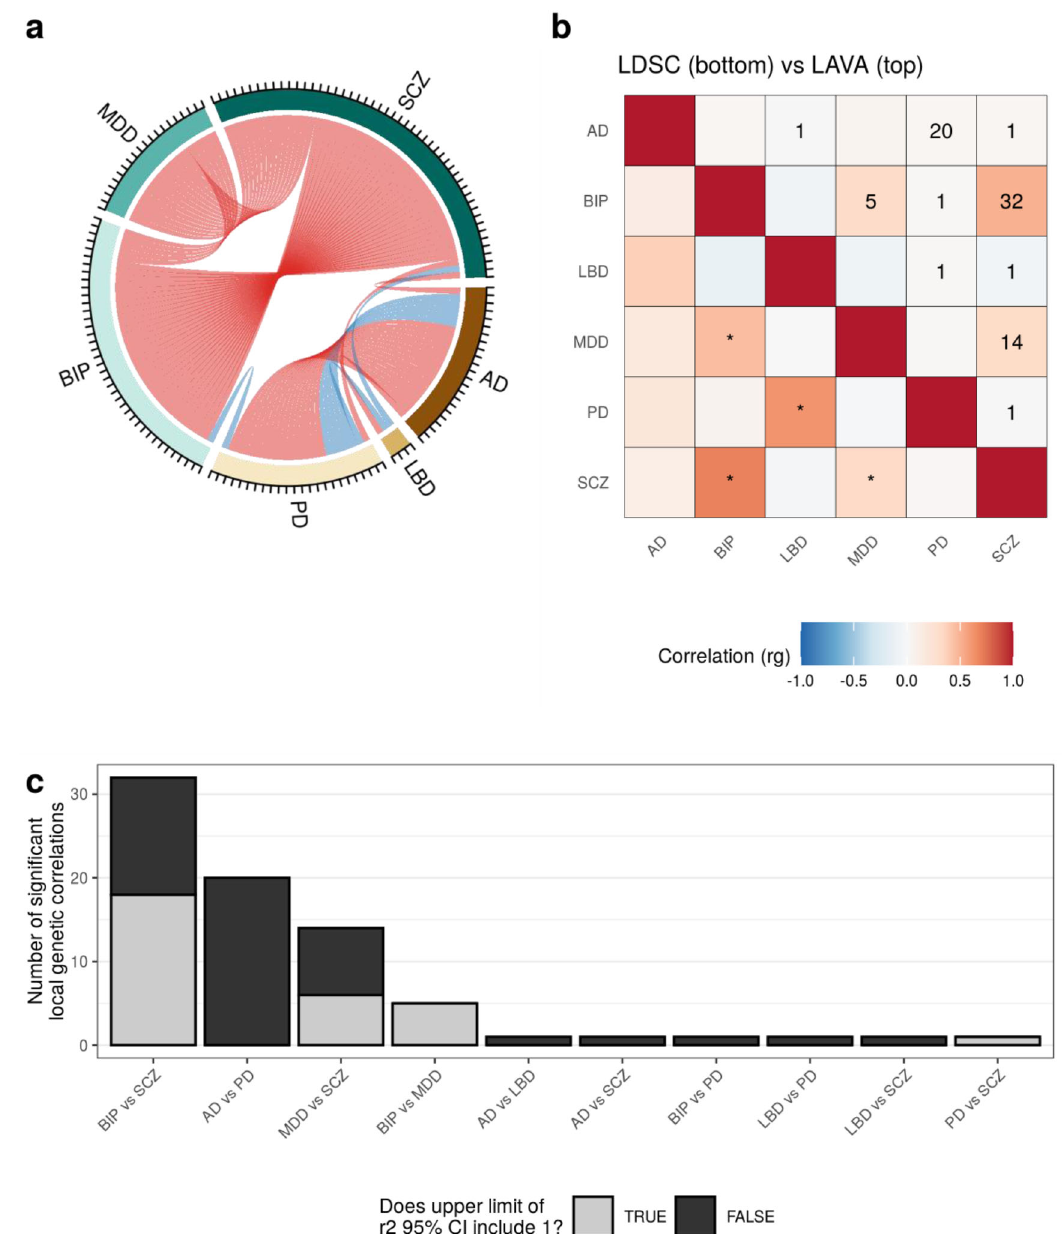
Fig. 1 Overview of local and global genetic correlations between neurodegenerative diseases and neuropsychiatric disorders. a Chord diagram showing the number of signi fi cant bivariate local r g s ( p < 0.05/1603) between each of the disease traits across all LD blocks. Positive and negative correlations are coloured red and blue, respectively. b Comparison between the global r g s estimated by LDSC (bottom) and the mean local r g from LAVA (top) across all tested LD blocks. Signi fi cant global r g s ( p < 0.05/15) are indicated with *. The number of signi fi cant local r g s is indicated by a number in each tile. c Bar plot showing the number of signi fi cant local r g s between disease trait pairs. The fi ll of the bars indicates the number of signi fi cant LD blocks for which the upper limit of the r 2 95% con fi dence interval (CI) included